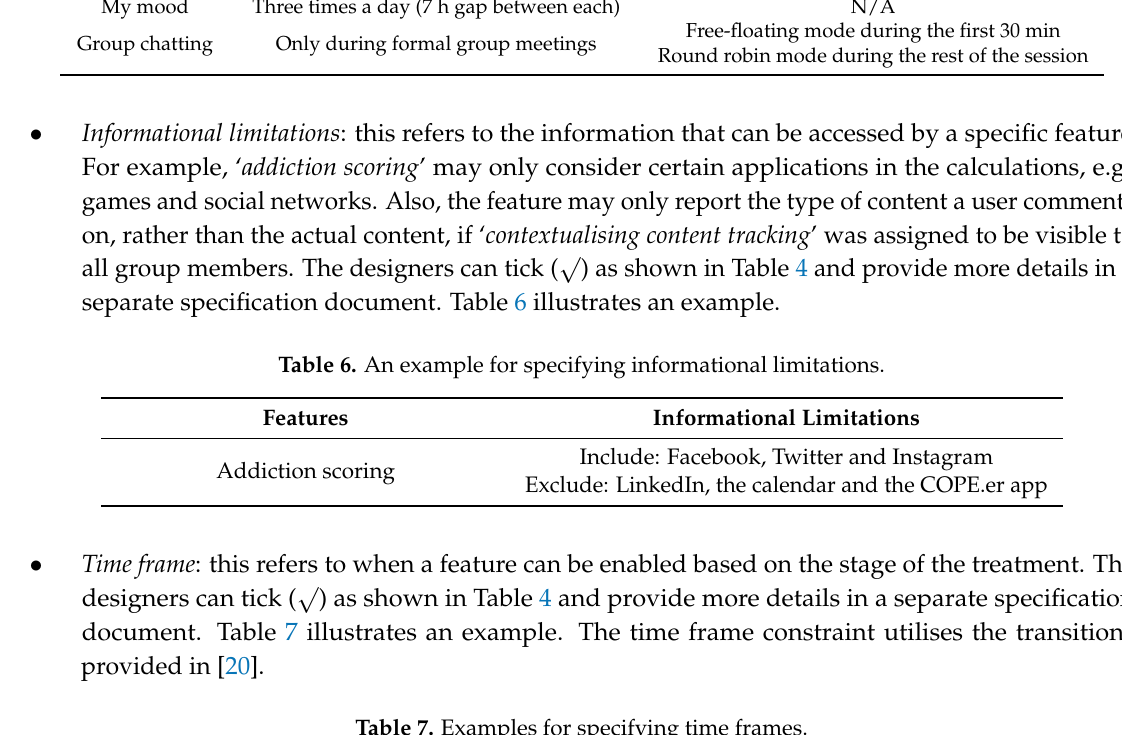
Table 7. Examples for specifying time